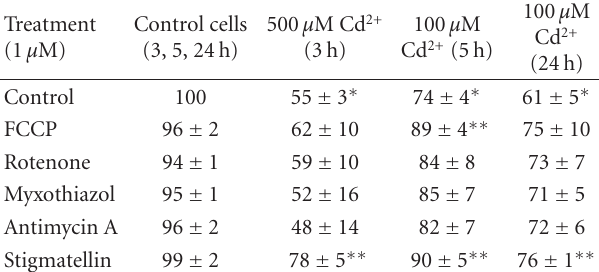
Table 4: Action of di ff erent respiratory chain e ff ectors on viability of PC12 cell assessed by LDH release after di ff erent time of incubation with di ff erent concentration of Cd 2+